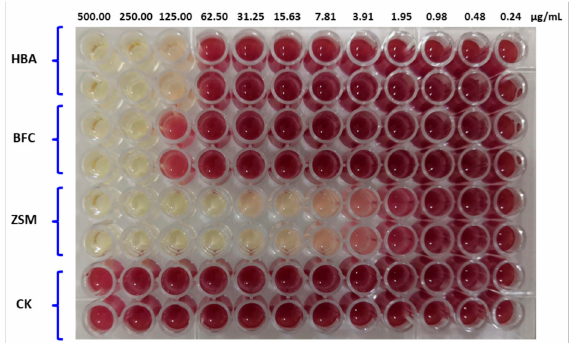
Figure 4. Determination of MIC value of novel fungicide HBA against A. avenae subsp. citrulli . Note: HBA: 4-hydroxybenzoic acid; BFC: benzo[b]furan-2-carboxaldehyde; ZSM: zhongshengmycin; CK: